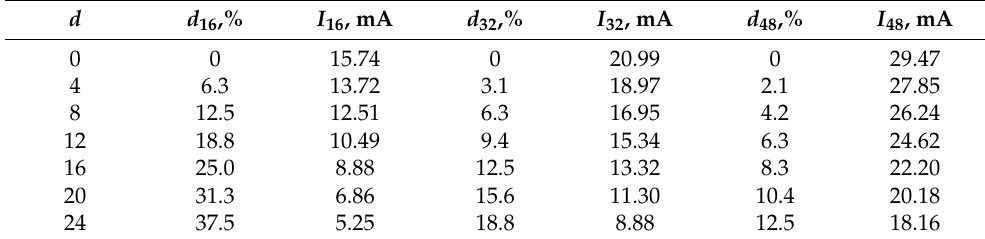
Table 3. Results of experiments for n = 16, 32 and